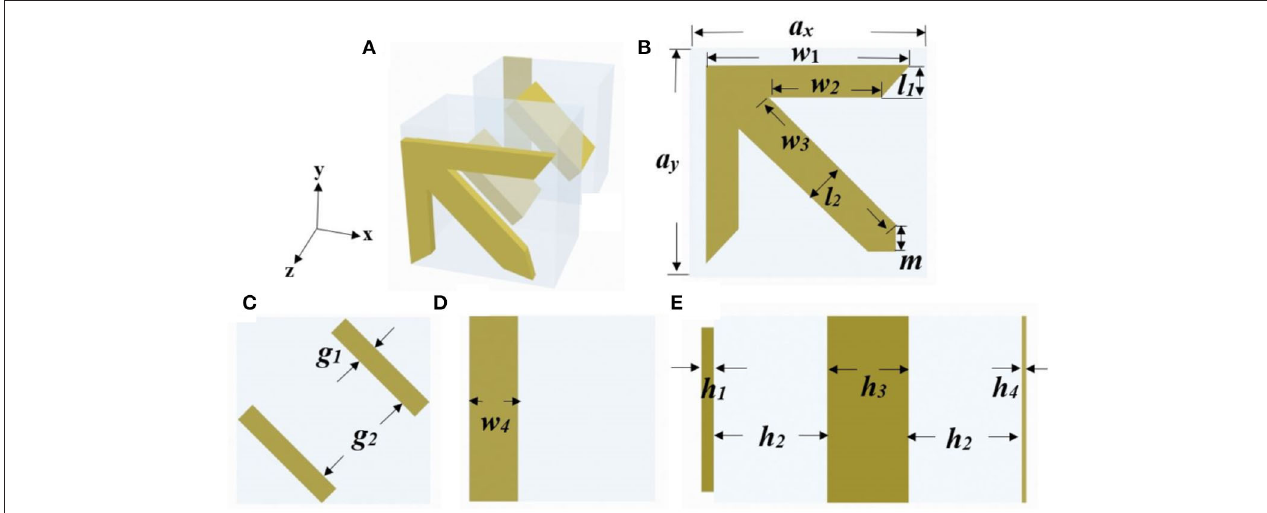
FIGURE 1 | Schematic illustration of the five-layer structure: (A) A three-dimensional (3D) perspective view. (B) The front view of the arrow structure layer. (C) The front view of the double-rod resonator layer. (D) The front view of the cut-wire layer. (E) The stacking scheme of L 1 , L 2 , L 3, and two insert dielectric